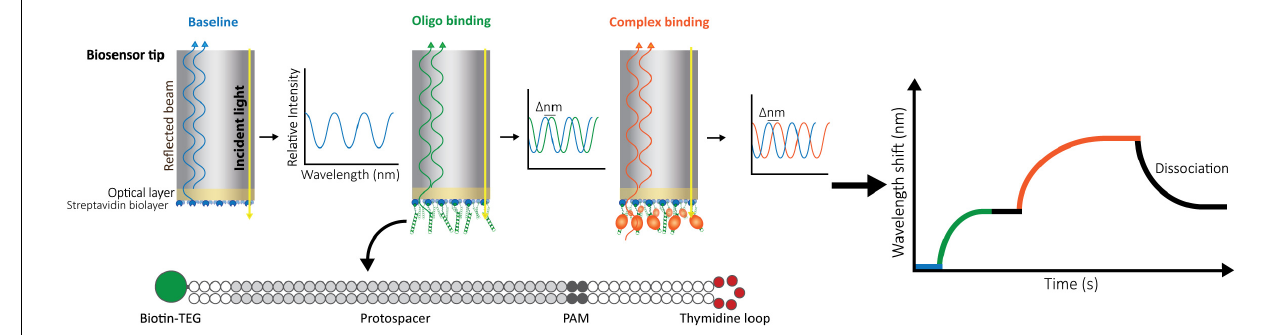
FIGURE 1 | Schematic representation of Bio-layer Interferometry (BLI). BLI measures the shifts in reflected white light upon changes in the thickness of the bio-layer. The measured shift depends both on the size and the affinity of the interactors. Bio-layers are coated with molecules (e.g., streptavidin) that allow the immobilization of one of the interactors. For this study, 5 (cid:48) -biotin-tagged oligonucleotides were used. The long dsDNA oligonucleotides have complementary arms separated by a 5-thymidine loop to allow for dsDNA hybridization. In addition, they contain a sequence complementary to the crRNA carried by the effector complex (protospacer) and a protospacer-adjacent motif (PAM). After baselining the light signal on buffer (blue), the oligonucleotide is added, binding to the streptavidin and generating a shift (green) that is also baselined by incubating the bio-layer back in buffer (black straight line). After signal stabilization, the label-free ribonucleoprotein complex is added, and the generated shift is recorded until equilibrium is reached (orange). Dissociation of the complex is then measured by transferring the bio-layer back into buffer (black